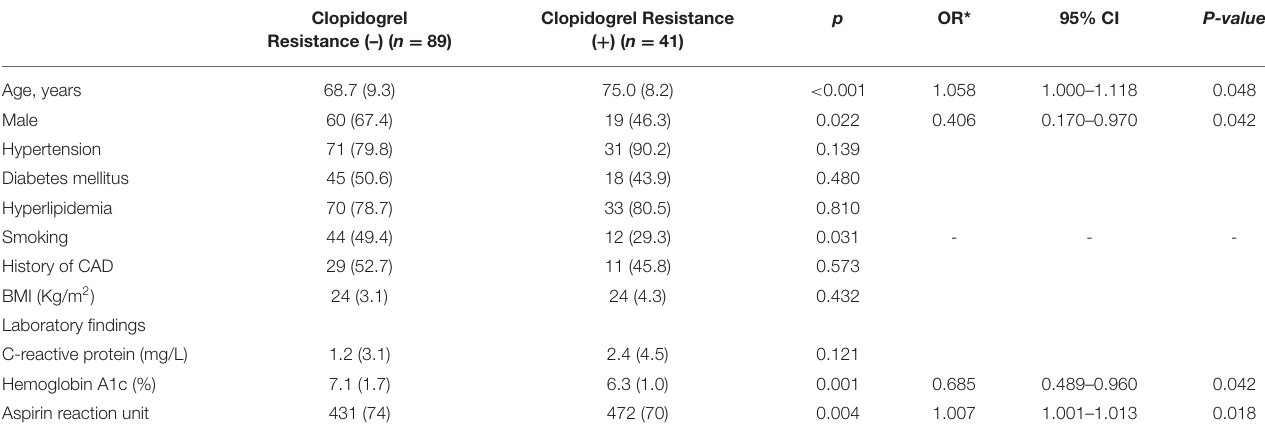
TABLE 3 | Factors associated with clopidogrel resistance after aspirin and clopidogrel treatment. Clopidogrel Resistance (–) ( n =